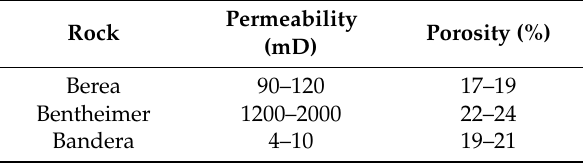
Table 1. Characteristics of sandstone core samples used in the